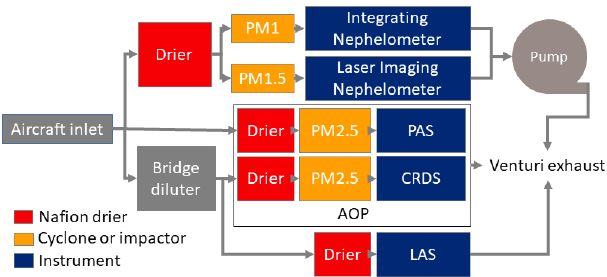
Figure 3. Partial diagram of aerosol sampling suite aboard NASA DC-8 during FIREX-AQ.